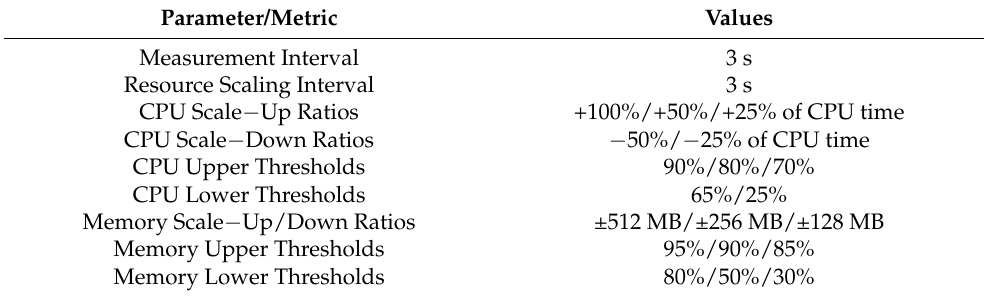
Table 2. Resource coordination and monitoring policies: based on the thresholds and scaling metrics, resource allocations (CPU and memory) of running containers can be independently adjusted. Parameter/Metric Values Measurement Interval 3 s Resource Scaling Interval 3 s CPU Scale − Up Ratios +100%/+50%/+25% of CPU time CPU Scale − Down Ratios − 50%/ − 25% of CPU time CPU Upper Thresholds 90%/80%/70% CPU Lower Thresholds 65%/25% Memory Scale − Up/Down Ratios ±512 MB/±256 MB/±128 MB Memory Upper Thresholds 95%/90%/85% Memory Lower Thresholds